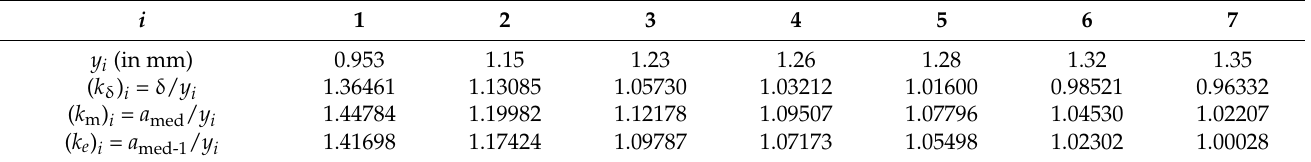
Table 12. Values of the proportionality coefficients ( k δ ) i , ( k m ) i and ( k e ) i for a pole with double arm in the console, subject to compression, bending and torsion ( δ = 8.2443 µ m; a med = 8.9006 µ m; a med-1 = 9.084 µ